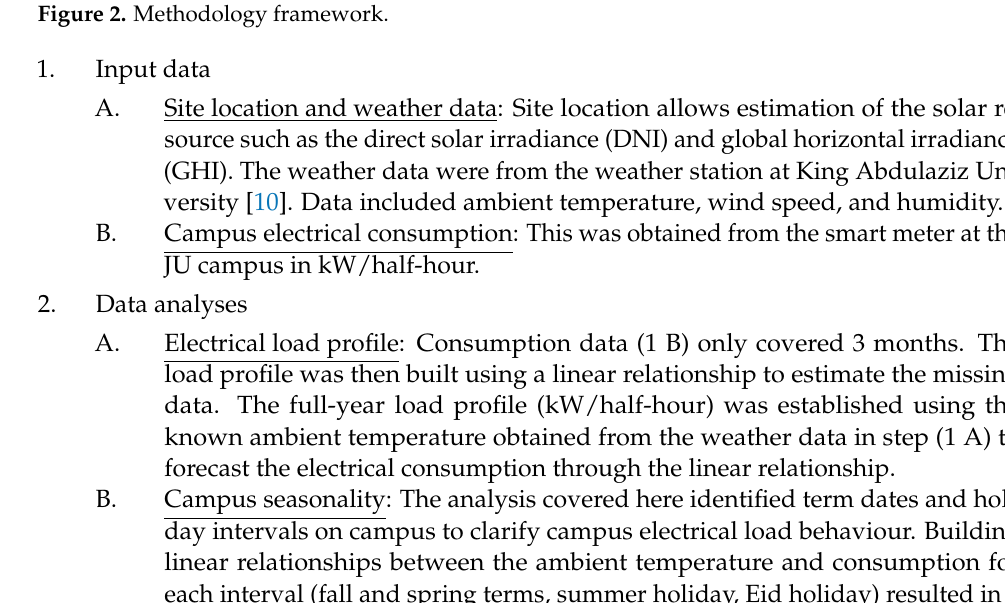
Figure 2. Methodology